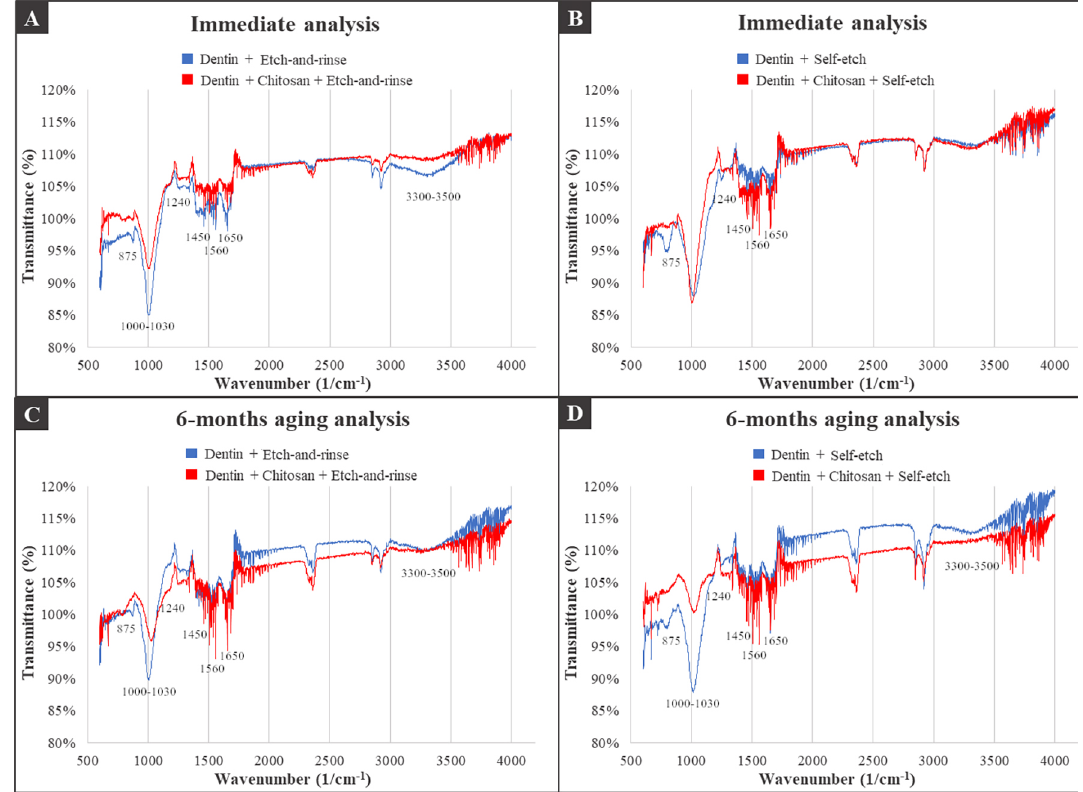
Figure 6- FTIR spectroscopy images of specimens with and without chitosan treatment: A) Etch-and-rinse adhesive - Immediate analysis; B) Self-etch adhesive - Immediate analysis; C) Etch-and-rinse adhesive - 6-months degradation; D) Self-etch adhesive - 6-months degradation. Carbonate (875 cm-1). Phosphate (1000-1030 cm-1). Amide III (1240 cm-1). CH2 (1450 cm-1). Amide II (1560 cm-1). Amide I (1650 cm-1). OH (3300-3500